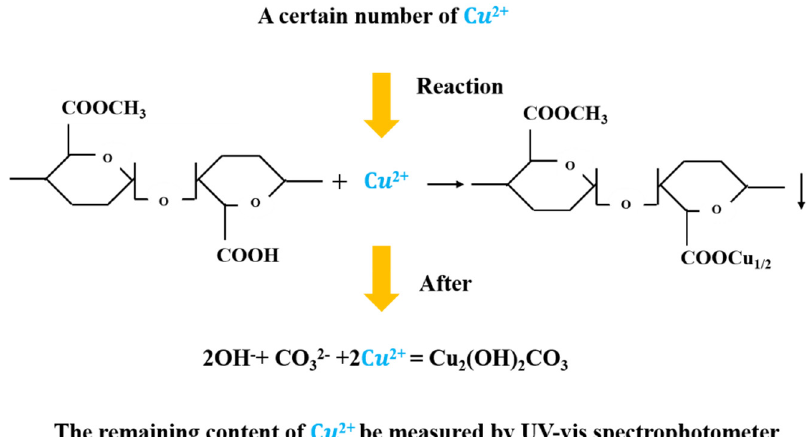
Figure 3. Mechanism of pectin content determination by copper ion colorimetry.